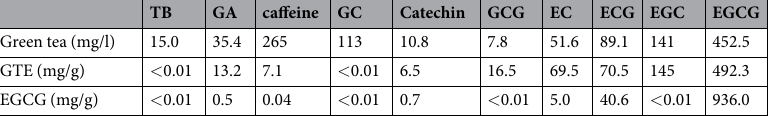
Table 2. Composition of the interventions. TB, theobromine; GA, gallic acid; GC, gallocatechin; GCG, gallocatechin gallate; EC, epicatechin; ECG, epicatechin gallate; EGC, epigallocatechin; EGCG, epigallocatechin gallate; GTE, green tea extract.